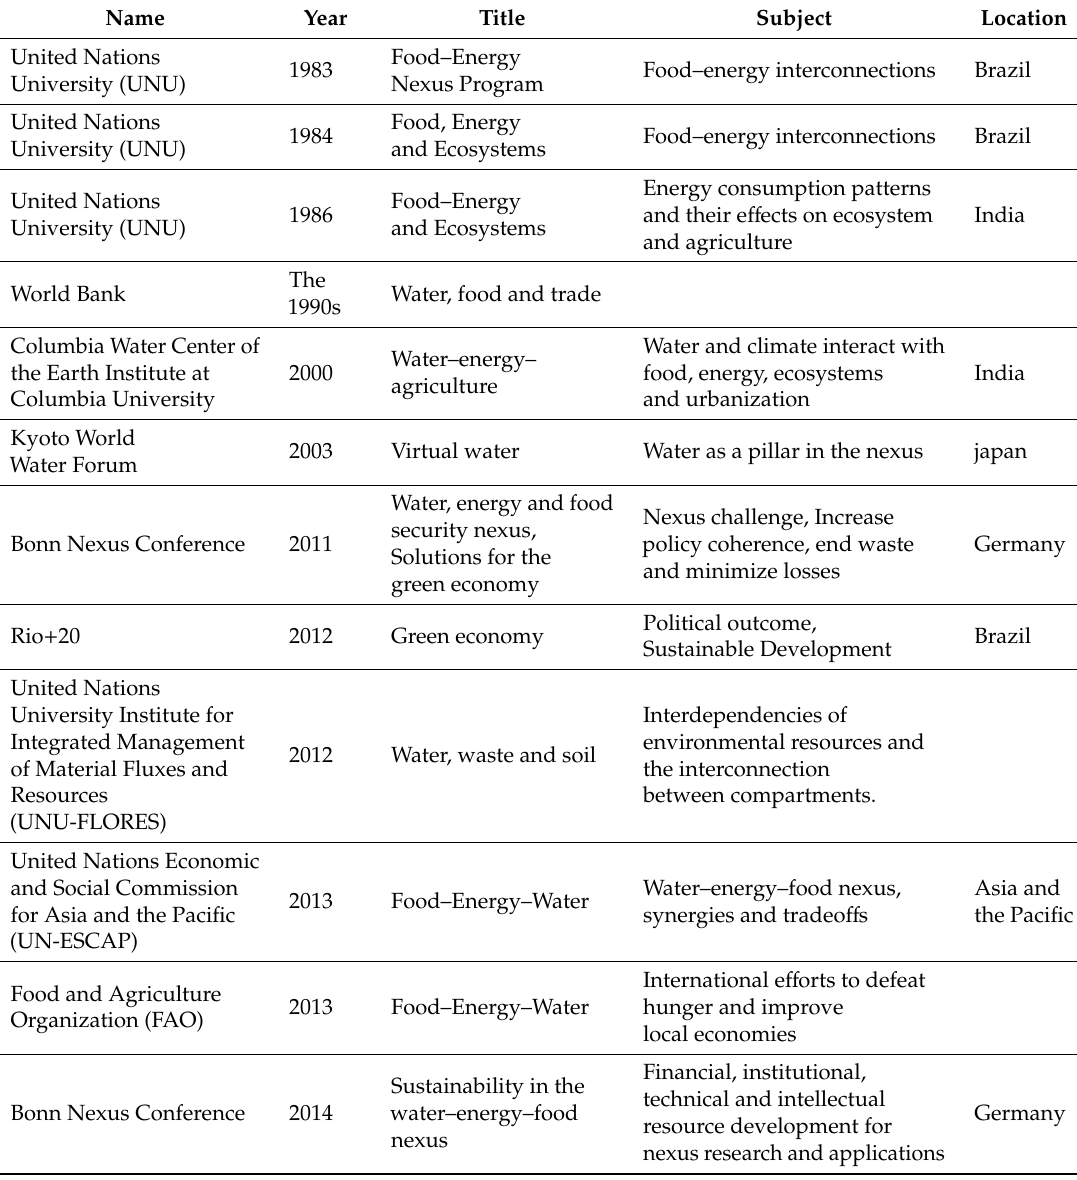
Table 4. Committee and conference information about